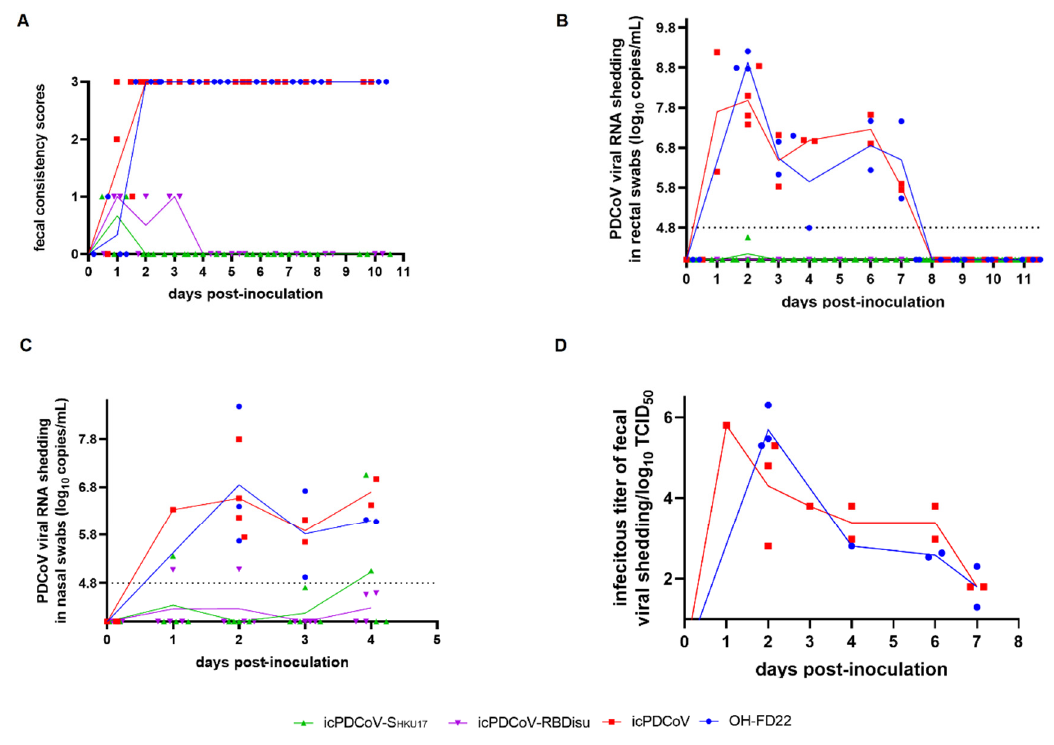
Figure 4. Evaluation of the replication and pathogenesis of recombinant viruses icPDCoV, icPDCoV-S HKU17 and icPDCoV- RBD ISU in 4-day-old Gn piglets. OH-FD22 group was positive control. Each line represents the mean value of each group and the values of individual Gn piglets are also shown: ( A ) Fecal consistency scores (0, solid; 1, pasty; 2, semiliquid; and 3, liquid. score of ≥ 2 was considered diarrhea.), ( B ) Fecal PDCoV RNA shedding profile, ( C ) Nasal PDCoV RNA shedding profile, and ( D ) Infectious PDCoV shedding titers from fecal samples.